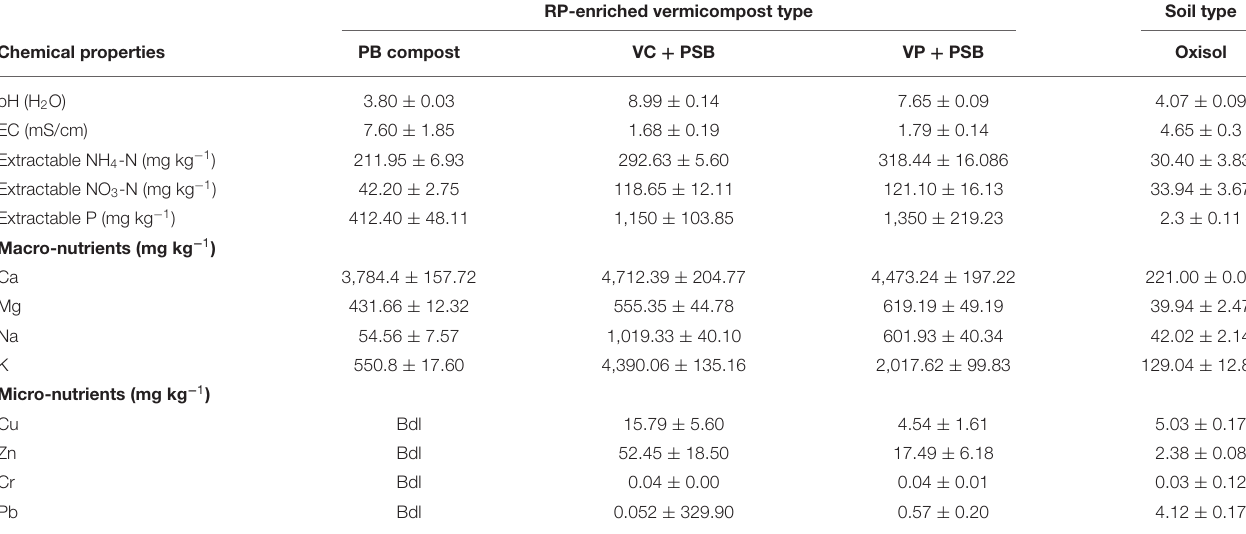
TABLE 1 | Macro and micro-nutrient content of rock phosphate (RP) cow and pig manure vermicompost and soil type. RP-enriched vermicompost